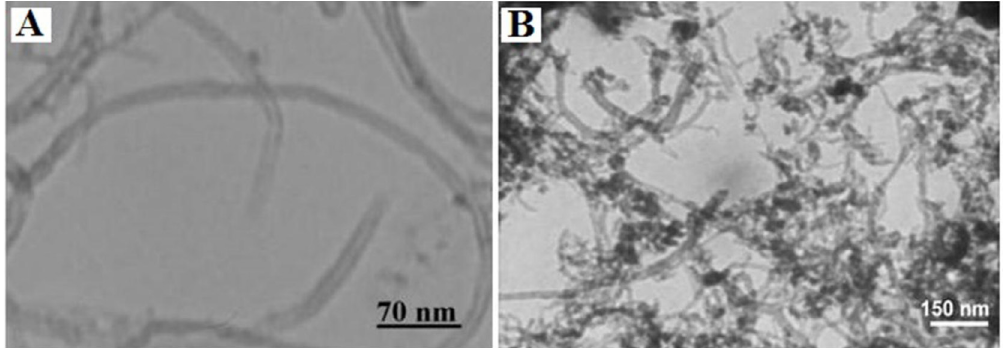
Fig. 3. Typical TEM images of (A) MWCNTs, (B) Fe